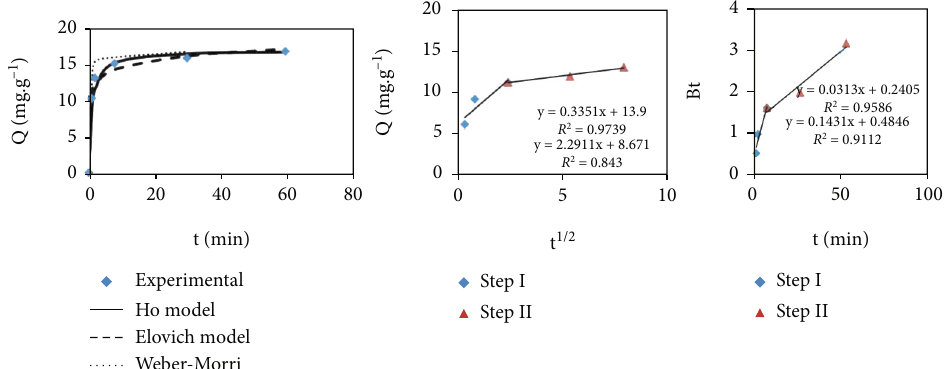
Figure 9: Experimental curves and the Ho, Elovich, and Webber-Morri models of the kinetic study of the adsorption of the Cd(II) ion in sodic